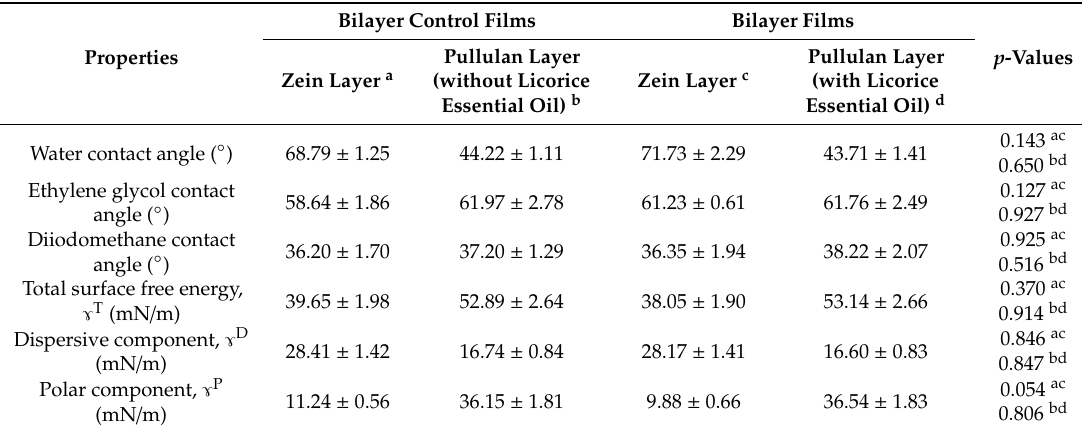
Table 2. Contact angles and surface free energy ( 7 ) of bilayer films.